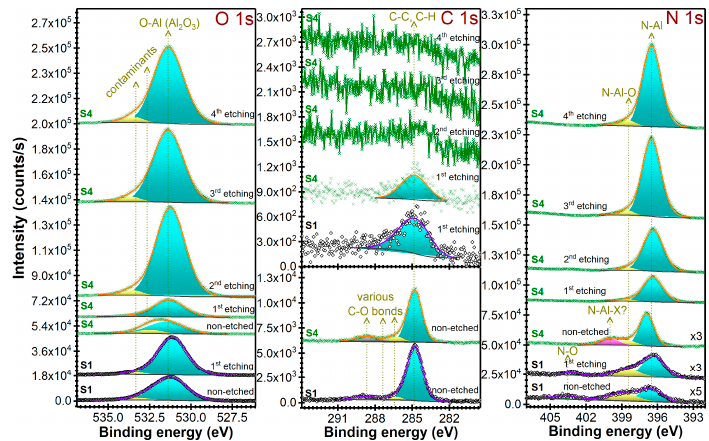
Figure 7. High-resolution XPS spectra of O 1s, C 1s and N 1s levels of S1 and S4 films, before and after the surface argon ion etching stages. Symbols—experimental data, Solid lines—peaks fit sum and individual identified components.